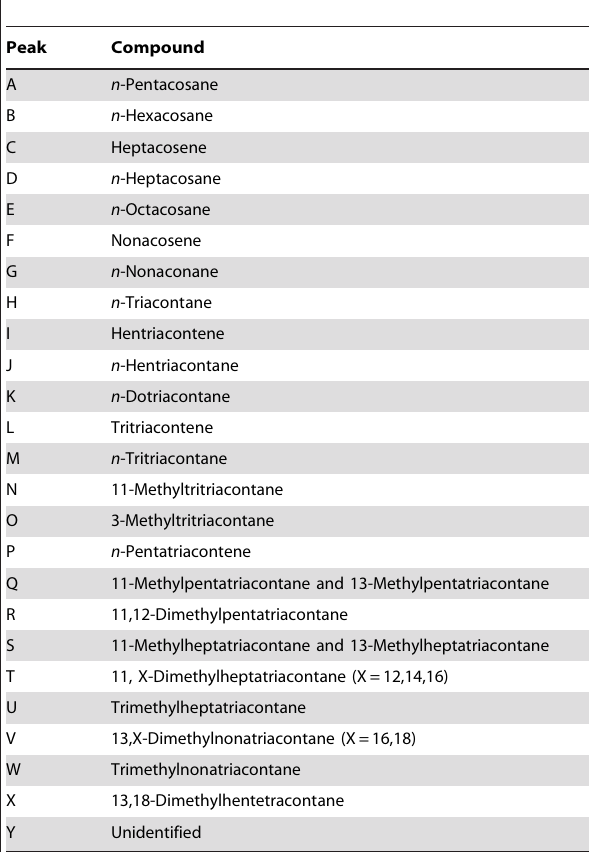
Table 1. Cutucular hydrocarbon components in Formica